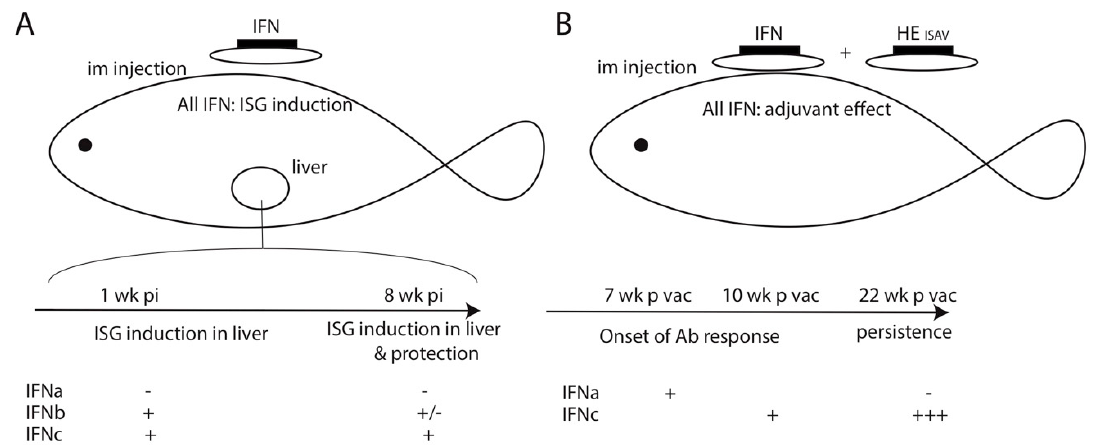
Figure 1. Effects of injection of plasmids encoding different type I interferon (IFN) on salmon susceptibility to virus and on vaccine efficacy when administered alone or in combination with a DNA vaccine to infectious salmon anemia virus (ISAV). ( A ). Injection of plasmids encoding type I IFN leads to contrasted levels of ISG induction in distant organs, and of protection eight weeks post-injection. ( B ). The co-injection of all plasmids encoding different type I IFN (a, b, and c) and of the DNA vaccine encoding ISAV hemagglutinin esterase (HE) protein affords adjuvant effect; however, the onset of Antibody (Ab)response and its persistence are higher for IFNc.